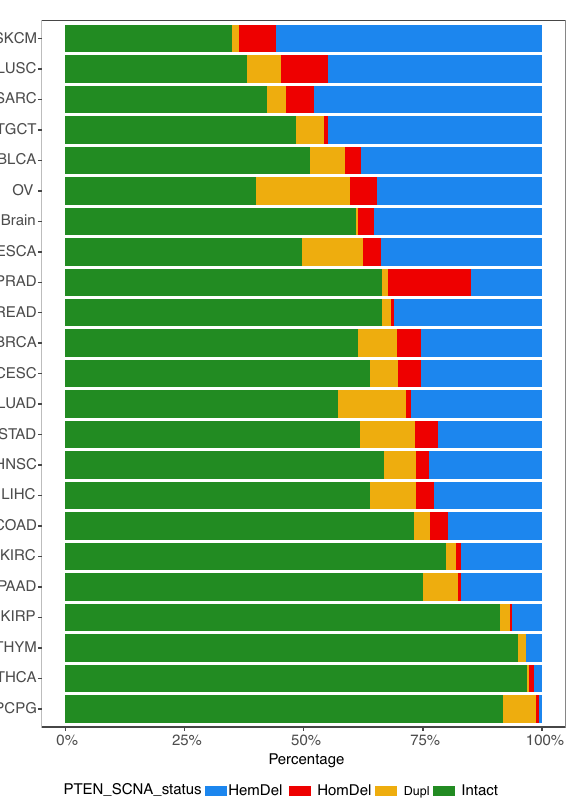
Figure 1. Relative percentages of PTEN Somatic Copy Number Alterations ( PTEN SCNA) from the 23 most common solid tumors taken from the 30 tumor types analyzed in the Pan-cancer cohort (shown in Table 1). Hemizygous deletions (HemDel) = blue; Homozygous deletions (HomDel) = red, Intact (no PTEN SCNA) = green, and gain/duplication = brown. The tumors are ranked by their combined frequencies of PTEN deletion (HemDel + HomDel) with melanomas (SKCM) having the highest overall frequency of PTEN deletion (top) and Pheochromocytoma and Paraganglioma (PCPG) having the lowest (bottom). Duplication or PTEN gain (Dupl) was not included in the rank order determination. Plotted using ggplot2 (https:// ggplo t2. tidyv erse.